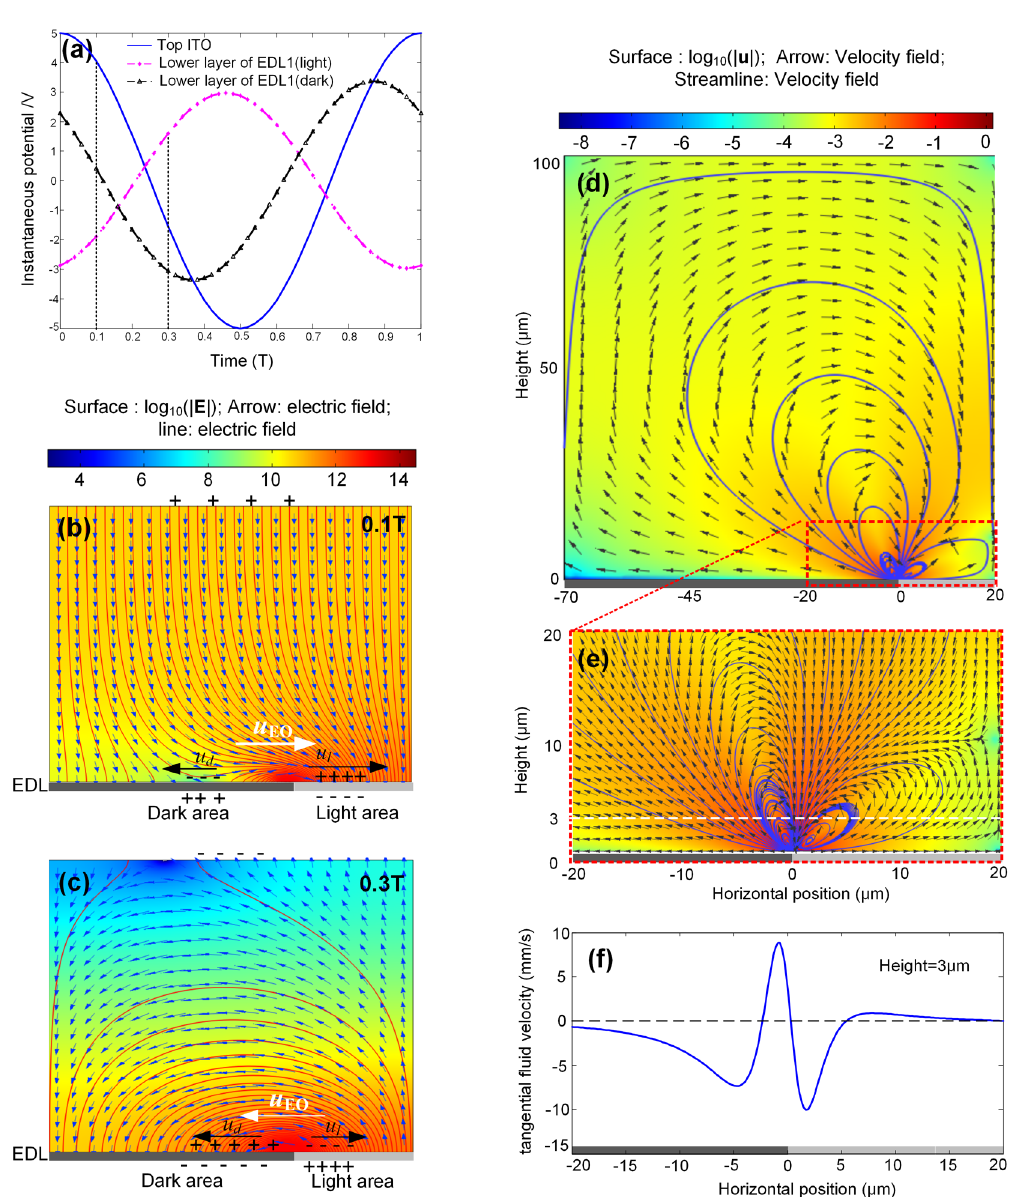
Figure 6. ( a ) Optically induced electric potentials at the lower layer of EDL1 (light and dark areas) and top ITO layer. ( b ) Electric field distribution in fluid chamber at t = 0.1 T . ( c ) Electric field distribution in fluid chamber at t = 0.3 T . T is the period of AC voltage. ( d ) Simulation result of the optically induced ACEO flow pattern. ( e ) ACEO flow velocity field around the border of the light (right side) and dark (left side) area of EDL1. ( f ) Tangential fluid velocity distribution along the horizontal coordinate at the height of 3 μm.